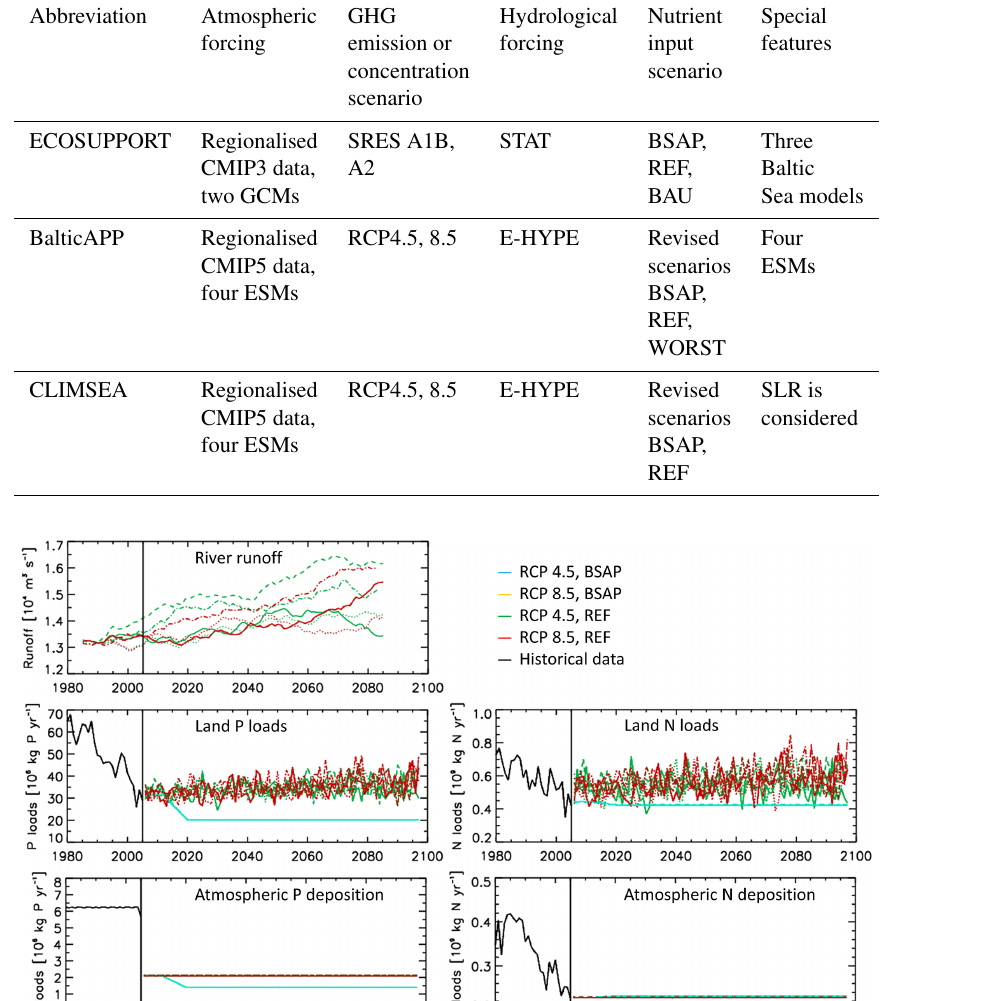
Table 4. Summary of the characteristics of the ECOSUPPORT, BalticAPP and CLIMSEA scenario simulations discussed in this study. For further details, the reader is referred to Tables 1 and 3. Abbreviations are defined in Table 5.